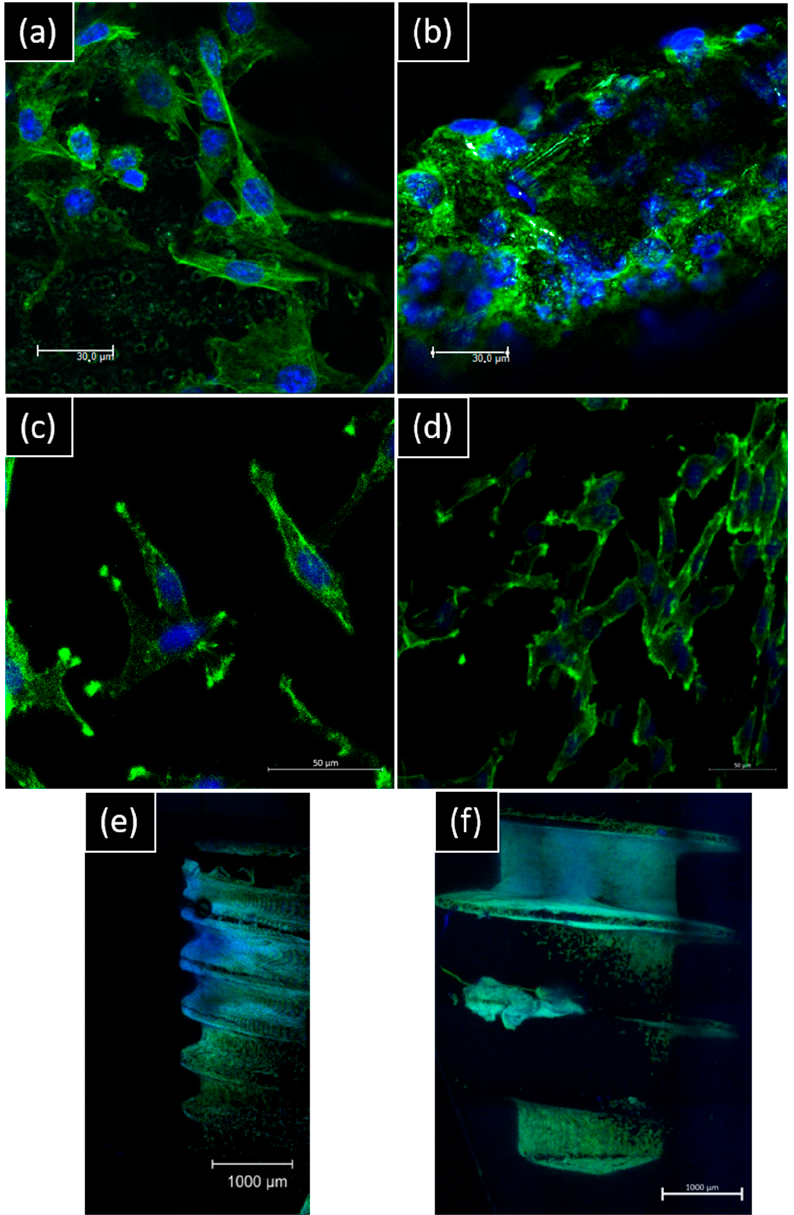
Figure 6. Representative confocal images of hGF and MG63 morphology on day 14 of contact with implants. hGF were in direct contact with ( a ) NB™ and ( b ) MC ® (scale bar = 30 µm). MG63 were in direct contact with ( c ) NB™ and ( d ) MC ® (scale bar = 50 µm); ( e ) NB™ and ( f ) MC ® (scale bar = 1000 µm). Nucleus-blue (DAPI) and cytoskeleton-green (ALEXA Fluor TM 488 Phalloidin).